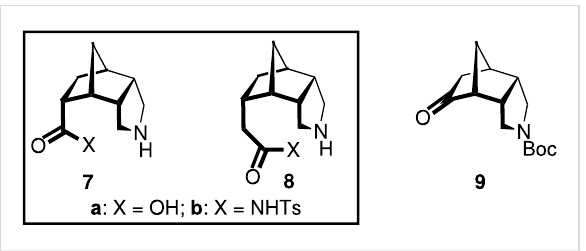
Figure 2: The targeted tricyclic amino acid derivatives 7 and 8 , and the key intermediate 9